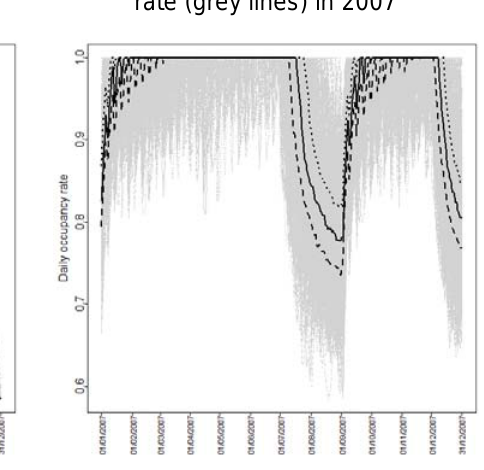
Figure 4. Simulated daily waiting list (grey lines) in 2007